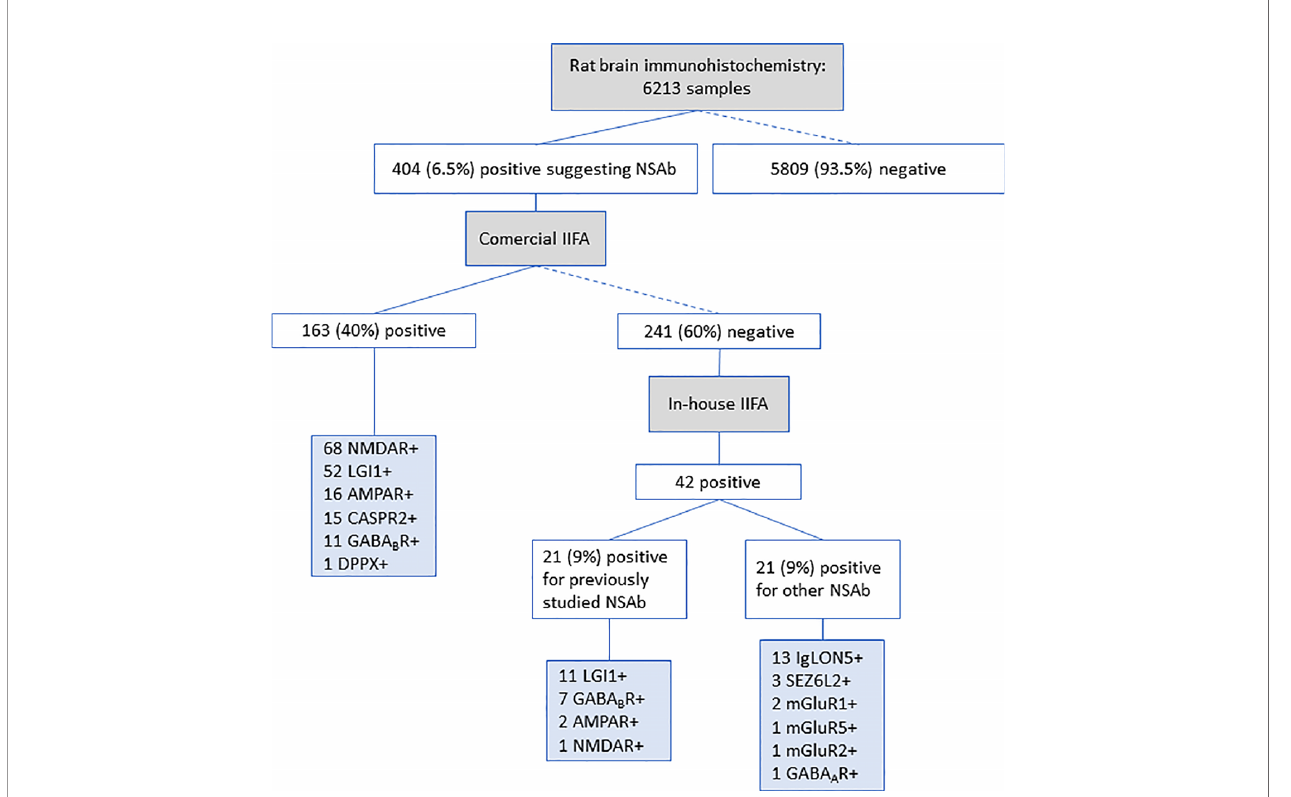
FIGURE 1 | Antibody detection in patients from Cohort A. Work fl ow used to identify IgG neuronal surface antibodies in a cohort of 6231 samples. IIFA, Indirect immuno fl uorescent assay; NSAb, Neuronal surface